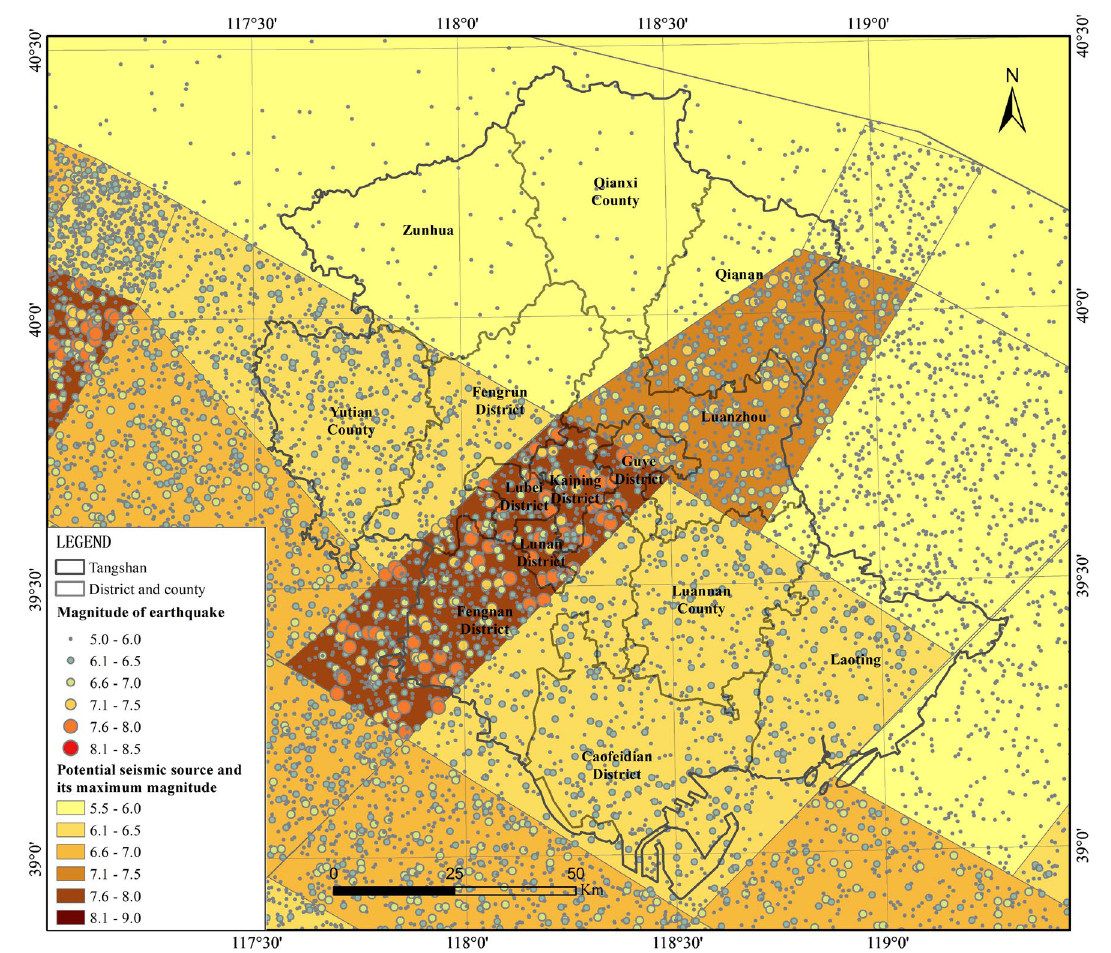
Fig. 1 Distribution of potential seismic source and 100,000-year stochastic seismic events in Tangshan City and its surrounding